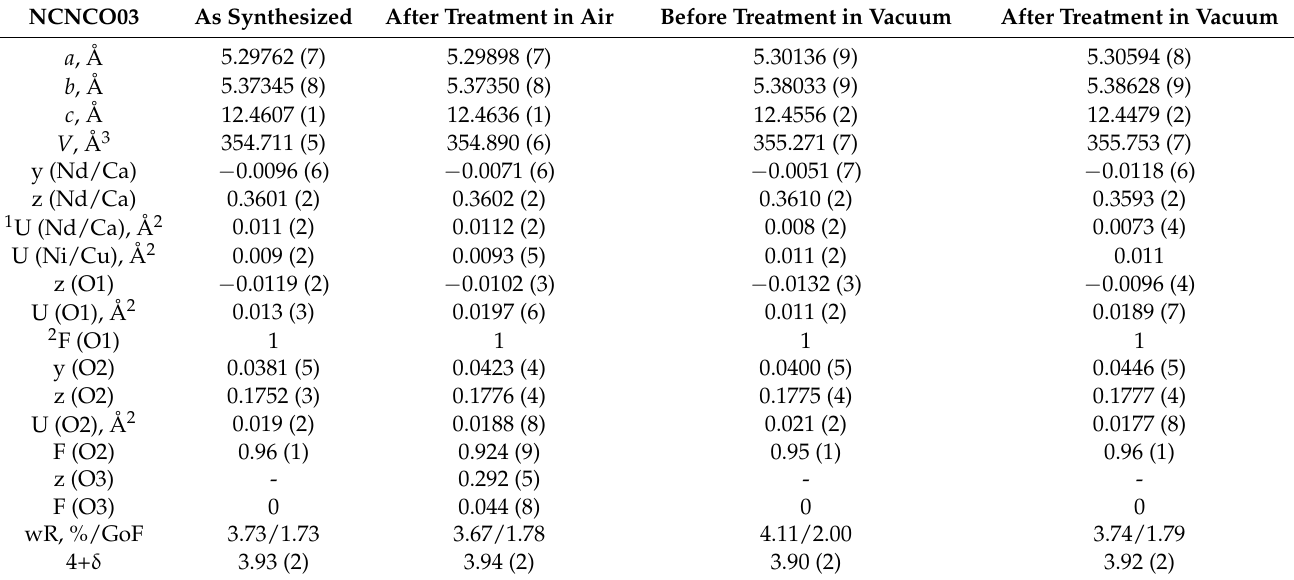
Table 2. Results of the Rietveld refinement of the NCNCO03 structure obtained at 50 °C by TOF NPD.